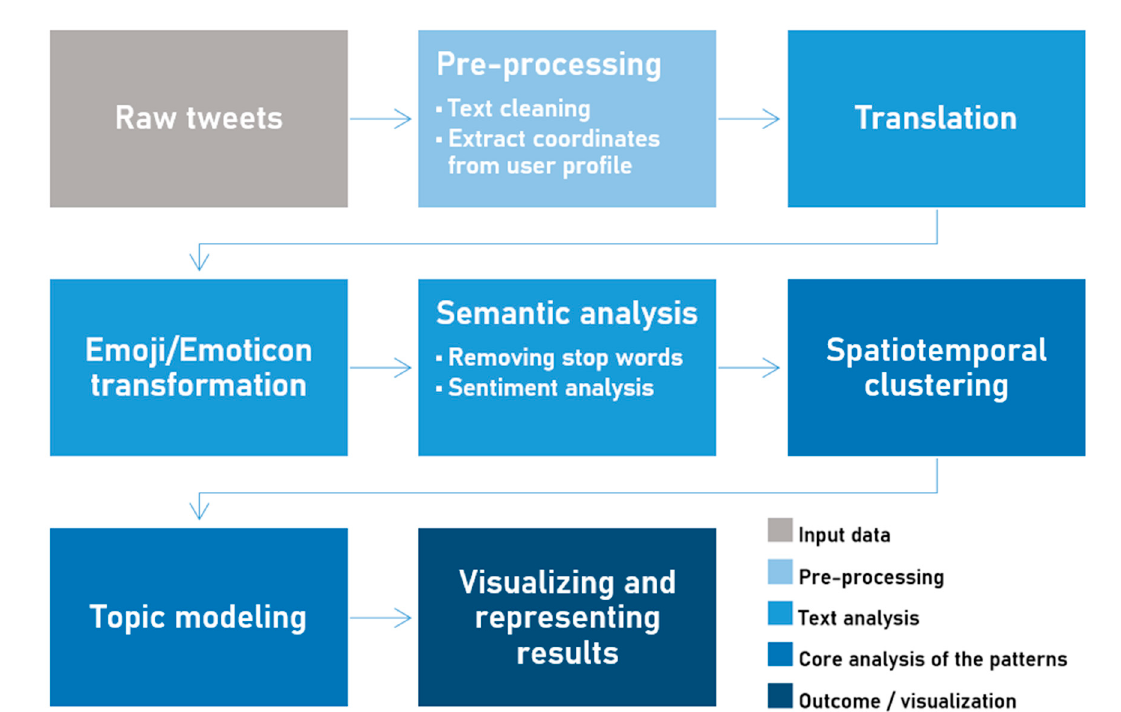
Figure 2. Overview of the Figure 1. Overview of the workflow.